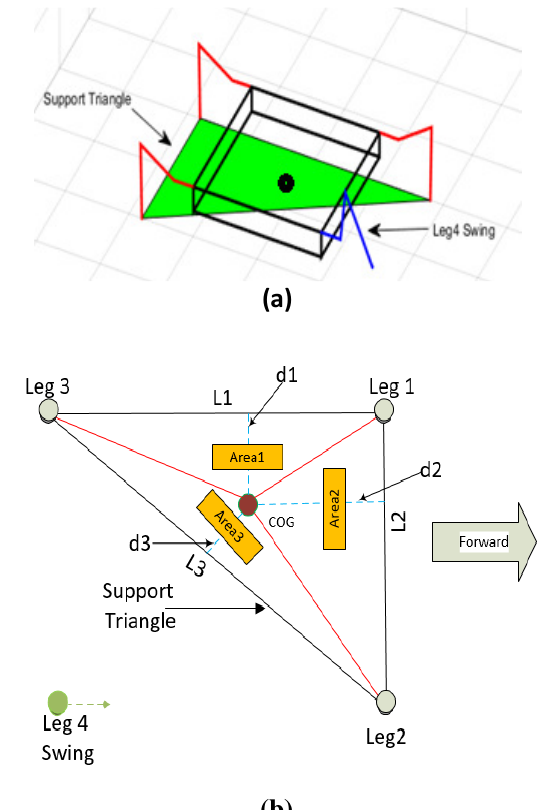
The first case, shown in Figure (8-a) when the quadruped robot leg4 swing in the air and legs (1, 2, and 3) on the ground. The supporting area will have three triangles, each triangle has a defined area (Area1, Area2, Area3) and the